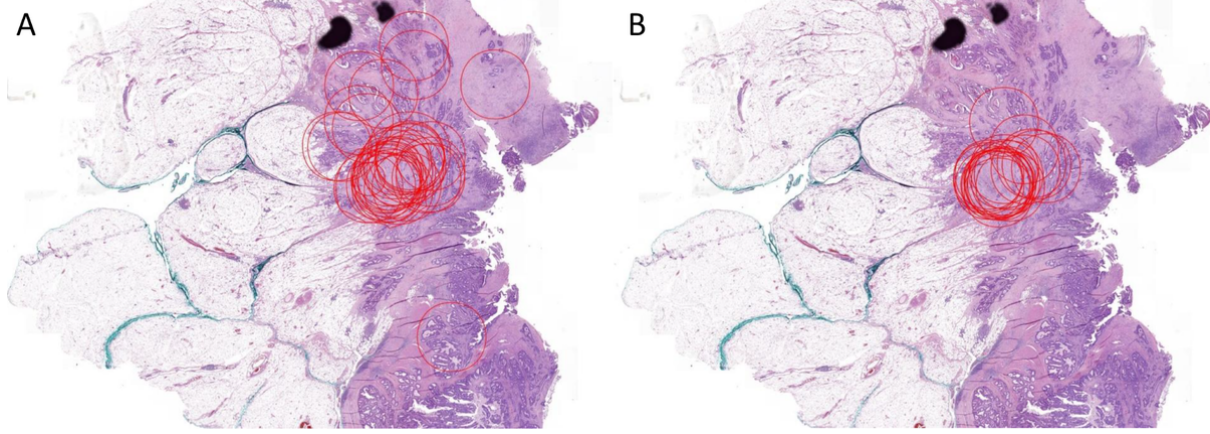
Figure 4. Example of improvement of selecting the most optimal area for scoring the tumor-stroma ratio. Diffuse spread of annotations was seen in the training set (A) compared to less variation of the scoring area in the test set